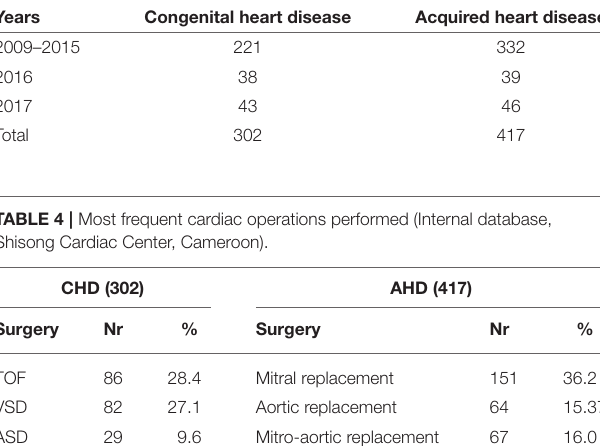
TABLE 3 | Surgical activity of the CC (Internal database, Shisong Cardiac Center, Cameroon). Years